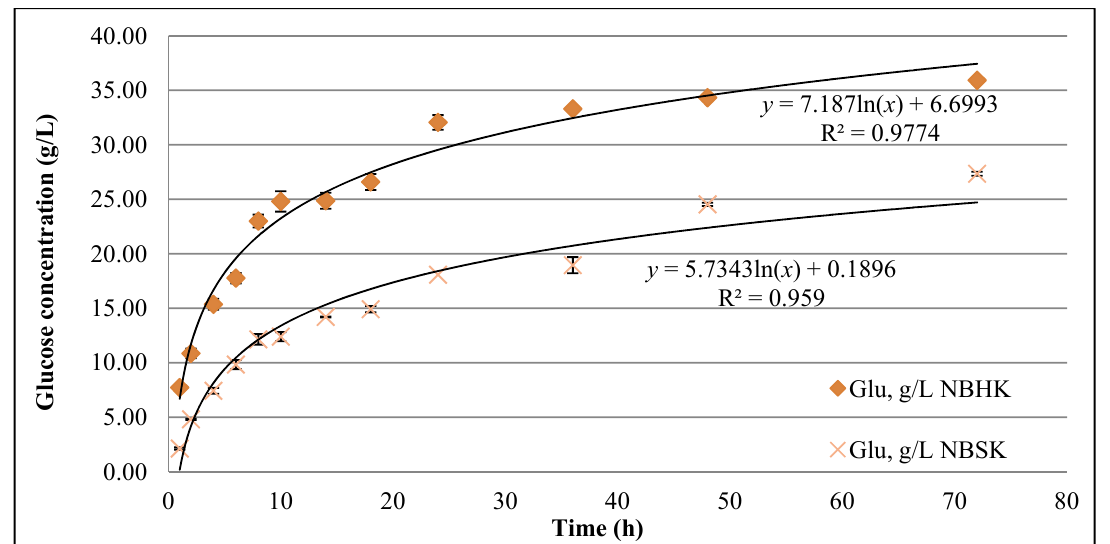
Figure 2. Glucose release from softwood pulp (NBSK) and hardwood pulp (NBHK) treated with a mixture of Cellic ® CTec2 and Cellic ® HTec2.